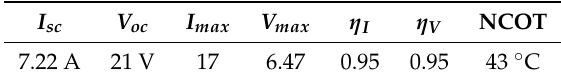
Table 3. PV modules specifications. NCOT: nominal cell operating temperature.